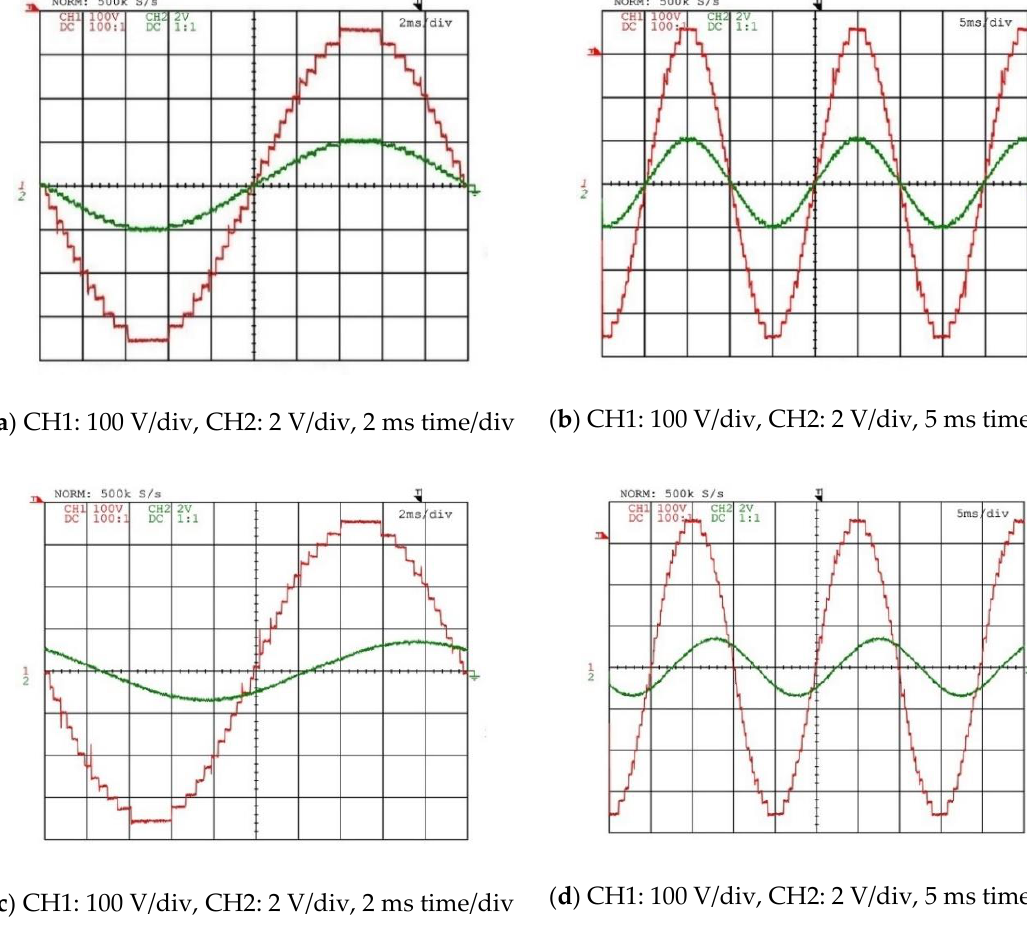
Figure 10. Experimental results of the proposed SCMLI: ( a ) R load (2 ms time/div); ( b ) R load (5 ms time/div); ( c ) RL load with a power factor of 0.75 (2 ms time/div); ( d ) RL load with a power factor of 0.75 (5 ms time/div).